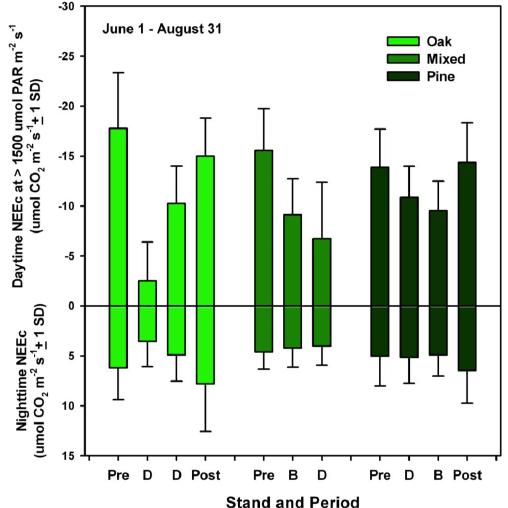
Figure 2. Daytime net CO 2 exchange (µmol CO 2 m − 2 s − 1 ) at ≥ 1500µmol PARm − 2 s − 1 and mean nighttime net CO 2 exchange during the summer (1 June–31 August) from 2005 to 2009 at the oak, mixed and pine stands. Pre = pre-disturbance, D = defoliation by gypsy moth, B = burned in prescribed fire, Post = post-disturbance. Statistics are in Table 3.